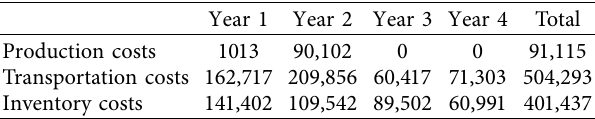
Figure 7: Network structure in year 4 and for the developed model with new financial Table 6: Production, transportation, and inventory costs for year for the developed model with new financial aspects.